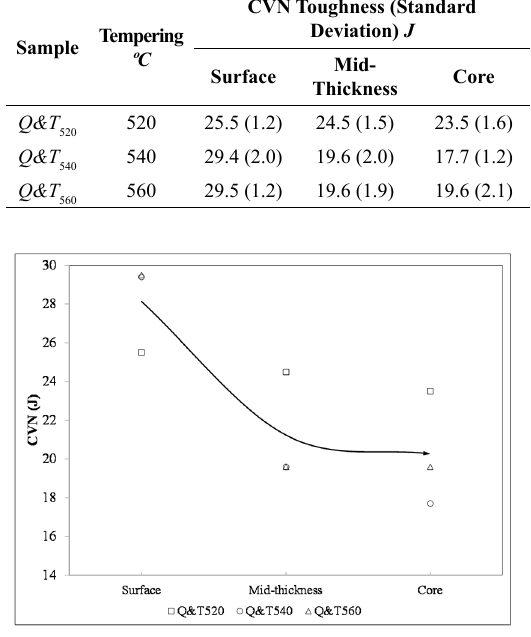
Figure 9. CVN toughness results for samples quenched and tempered at 520ºC (□), 540ºC (○) and 560ºC (Δ).